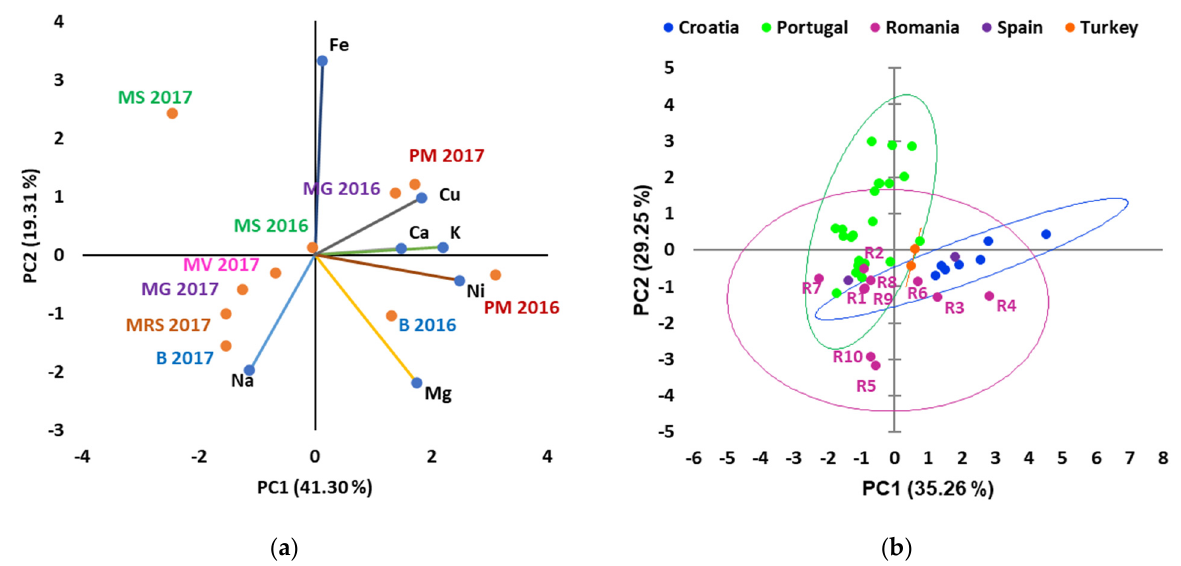
Figure 9. ( a ) PCA analysis based on mineral composition of fruits of different chestnut cultivars harvested in Romania in 2016 and 2017 (‘Précoce Migoule’—PM, ‘Bournette’—B, ‘Marsol’—MS, ‘Marissard’—MRS, ‘Marigoule’—MG and ‘Maraval’—MV) and ( b ) PCA analysis based on mineral composition of chestnut fruits harvested in some European countries .